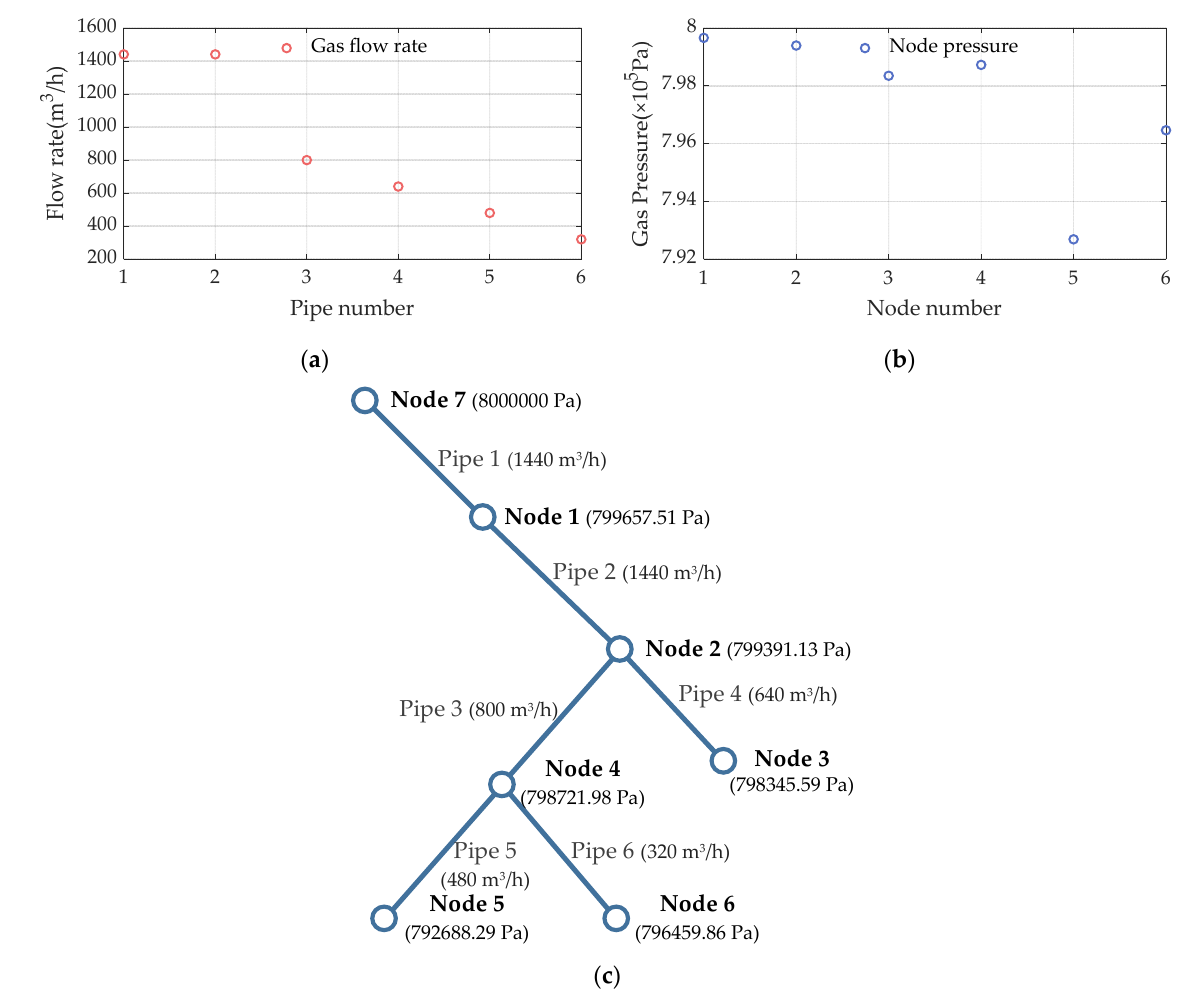
Figure 5. The simulation results of the isothermal steady-state natural gas network: ( a ) Gas flow rate; ( b ) node pressure; ( c ) annotation in the natural gas network.